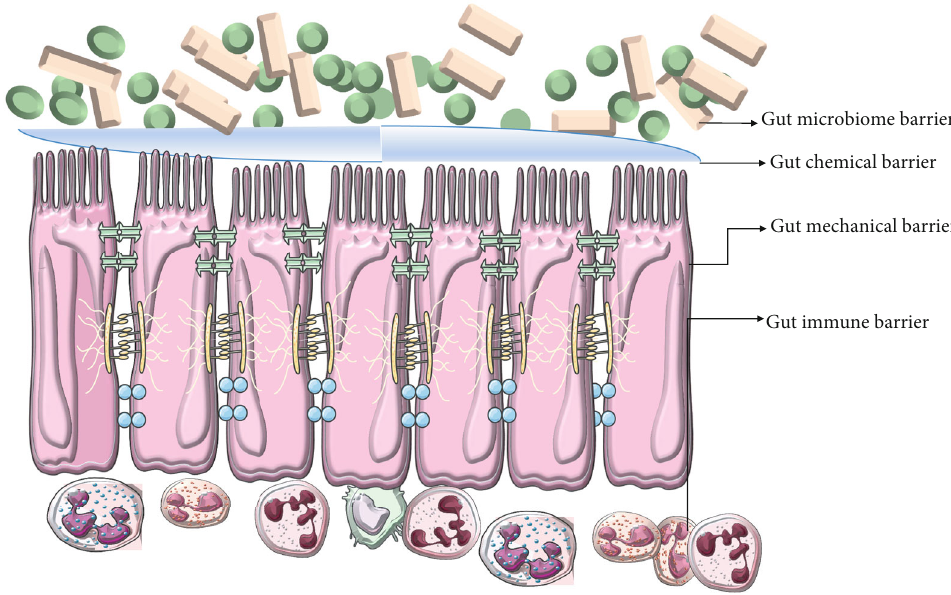
Figure 1: Compositional pattern of four gut